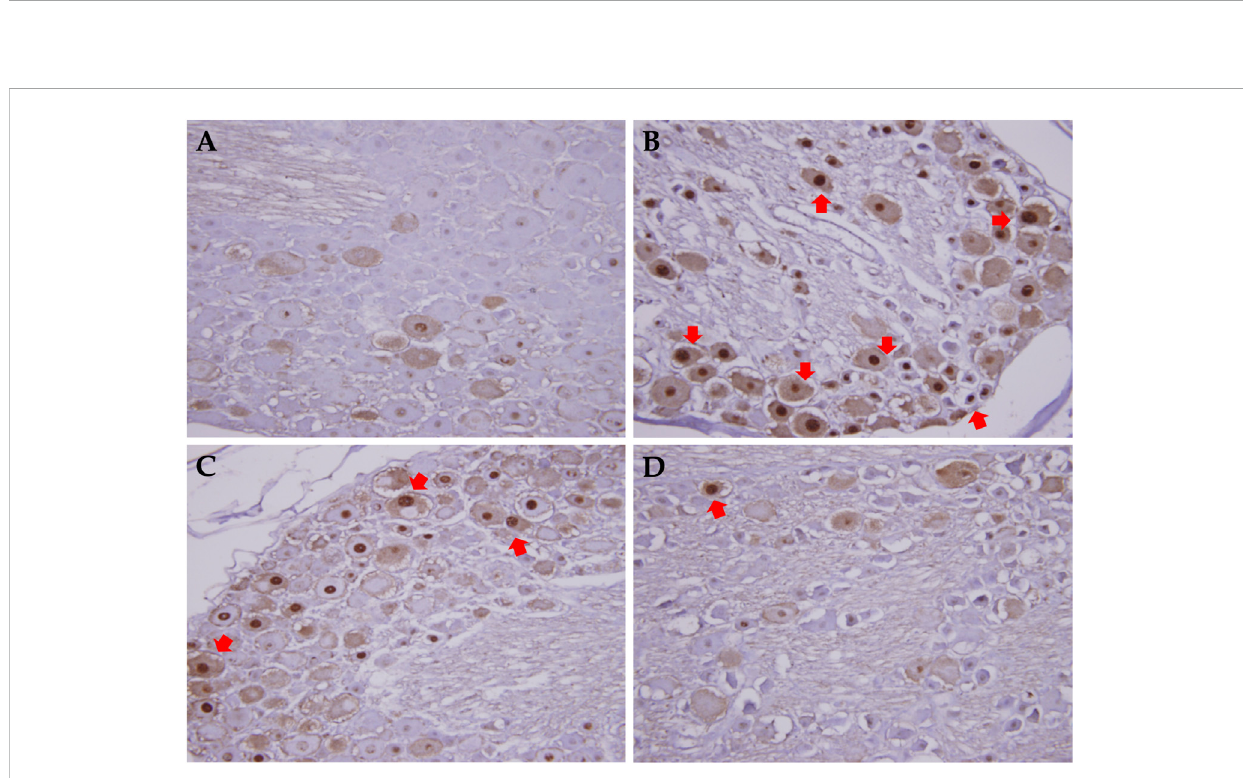
FIGURE 6 c-fos expression in dorsal root column in rats treated with or without XSLZJT pre- and post-paclitaxel treatment. (A) , the spinal cord of blank group showed nearly no c-fos staining; (B) , paclitaxel only group showed signi fi cant c-fos protein expression; (C) , c-fos expression in XSLJZT pre-treatment group; (D) , c-fos expression in XSLJZT post-treatment